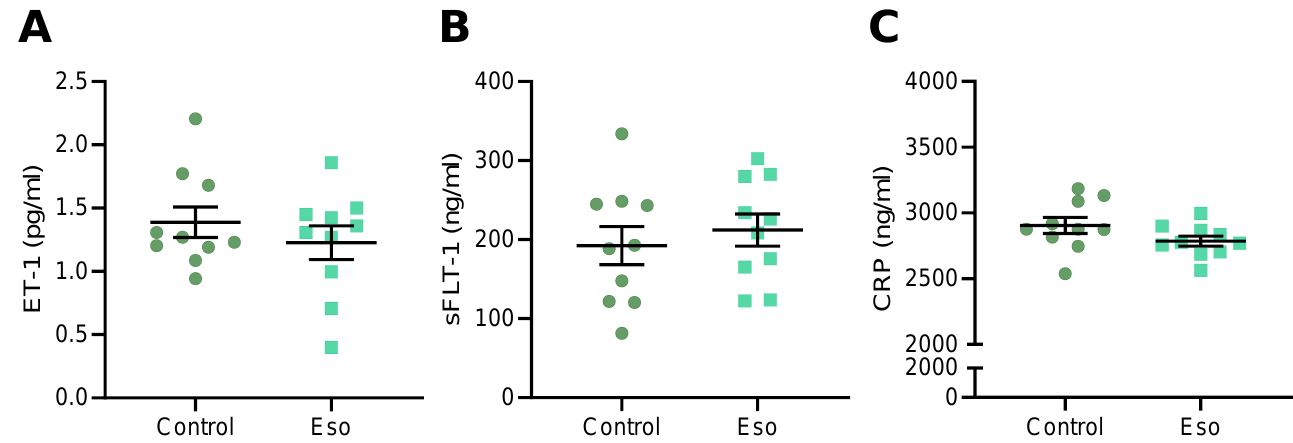
Figure 8. Effect of esomeprazole treatment on circulating ( A ) ET-1, ( B ) sFlt-1, and ( C ) CRP in obese L-NAME mice. Serum levels of these factors were assessed via ELISA. Obese mice receiving L-NAME treated with esomeprazole did not have altered circulating ( A ) ET-1, ( B ) sFlt-1, or ( C ) CRP compared to the controls. Data presented as mean ± SEM; n = 10 mice/group.